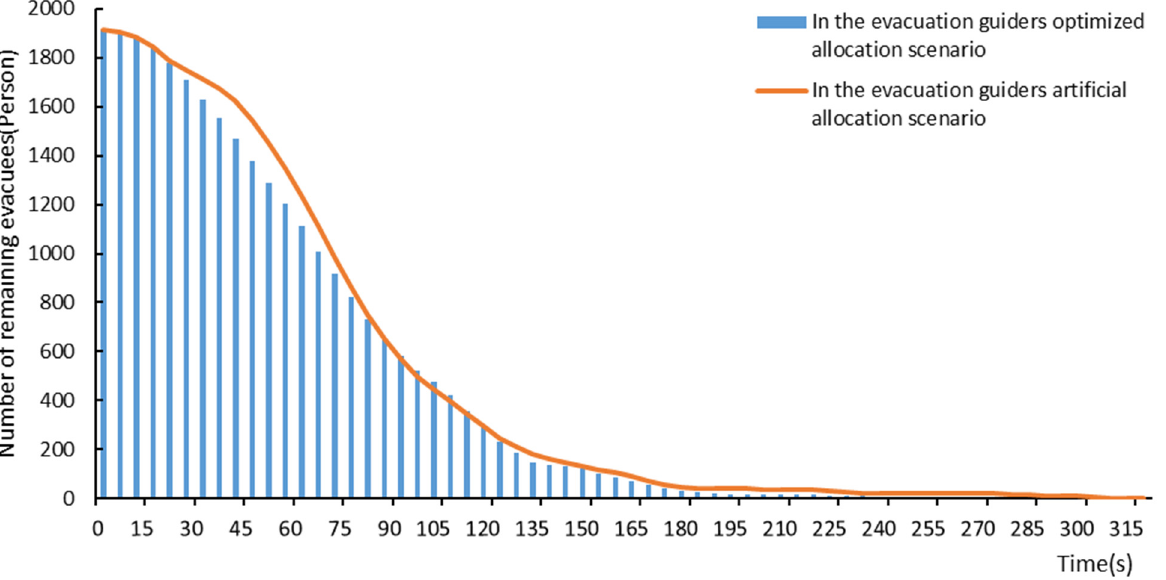
Figure 13. Comparison of evacuation efficiency between the “optimized allocation scenario” (the evacuation scenario using the proposed spatial allocation method of evacuation guiders) and “artificial allocation scenario” (the evacuation scenario using the artificial allocation method of evacuation guiders) at 14:30 on 5 May 2021.